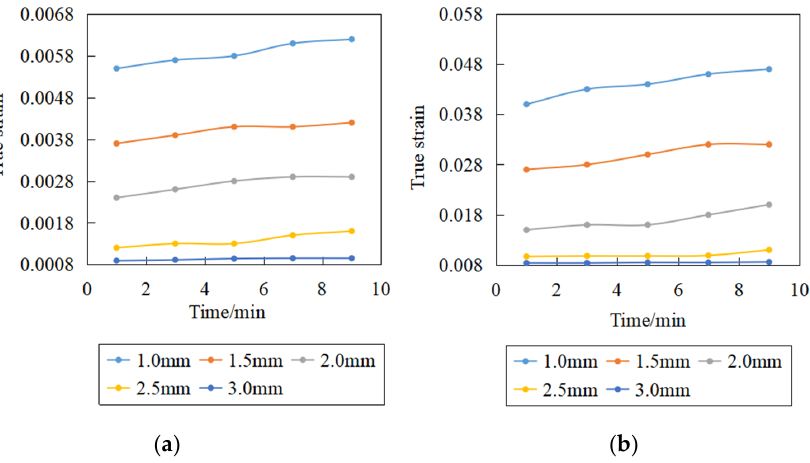
Figure 7. The true strain changes with time under different conditions. ( a ) The 310 austenitic chromium nickel stainless steel; ( b ) The 410 Ferritic stainless steel.